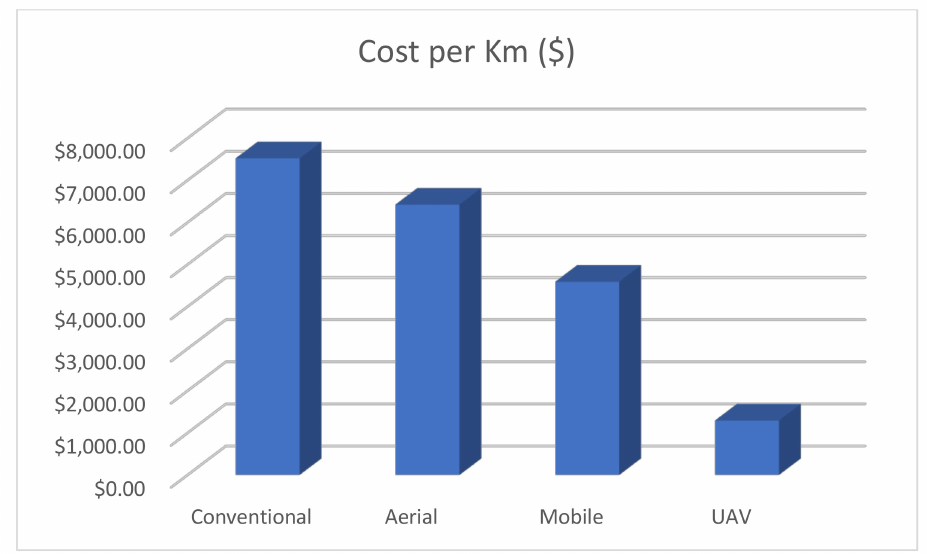
Figure 8. Per Km Cost for Di ff erent Data Collection